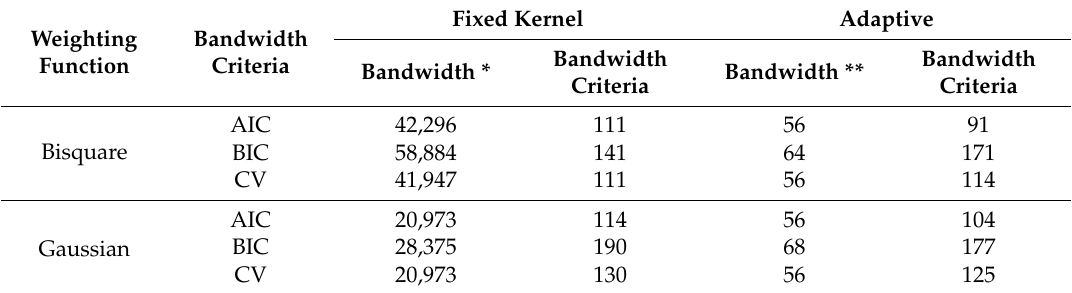
Table 1. GWR results using fixed and adaptive kernels during